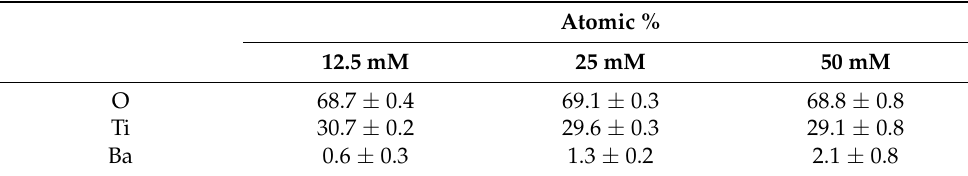
Table 1. The average actual percentages of Ba on each modified